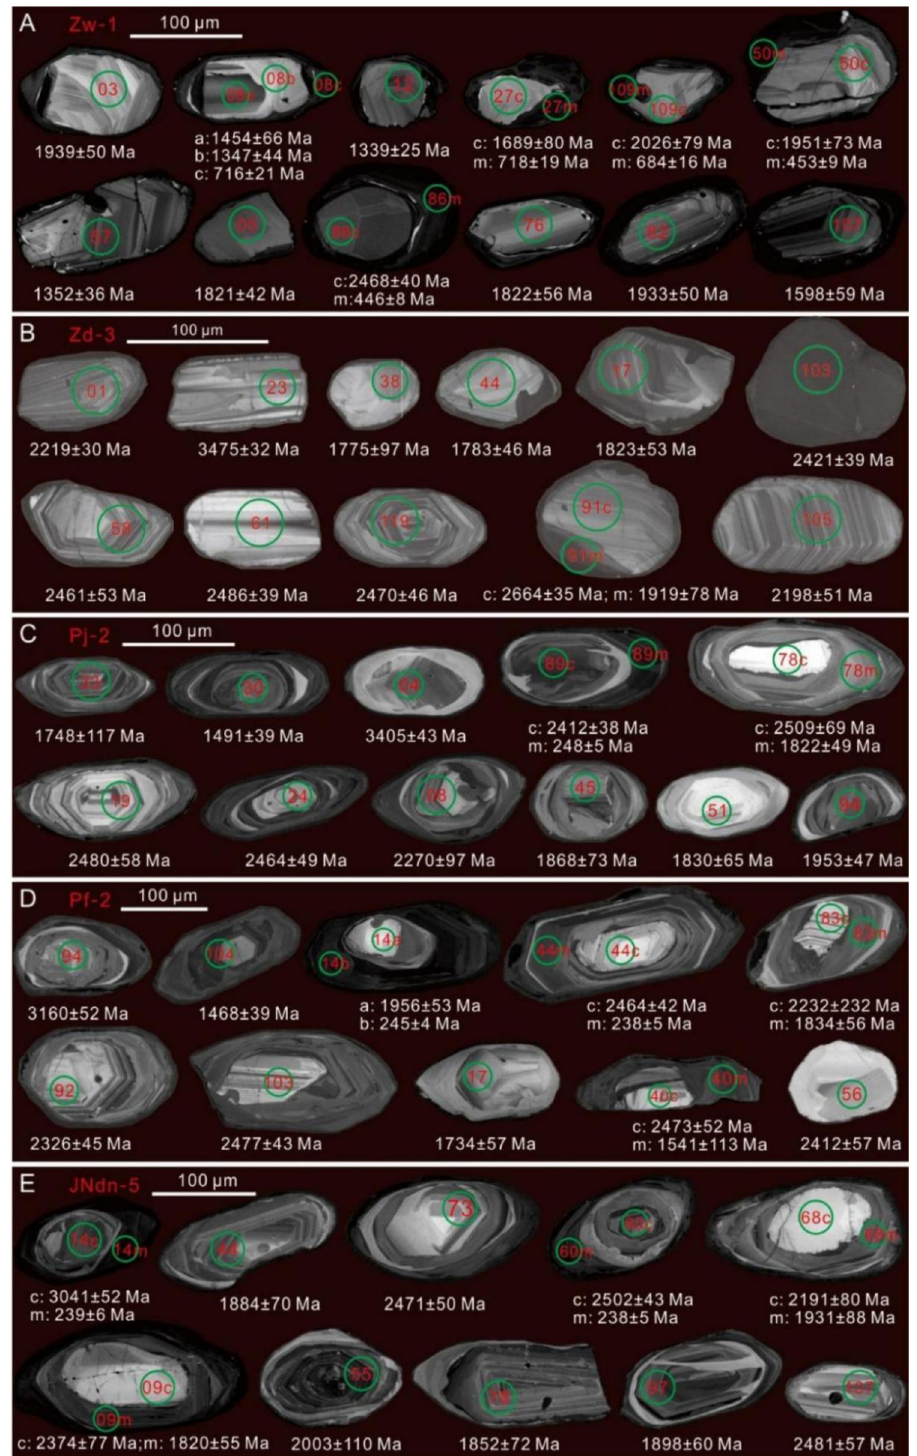
Figure 3. Cathodoluminescence (CL) images of representative zircons from the five analyzed meta- sediments (( A ) Zw-1; ( B ) Zd-3; ( C ) Pj-2; ( D ) Pf-2; ( E )